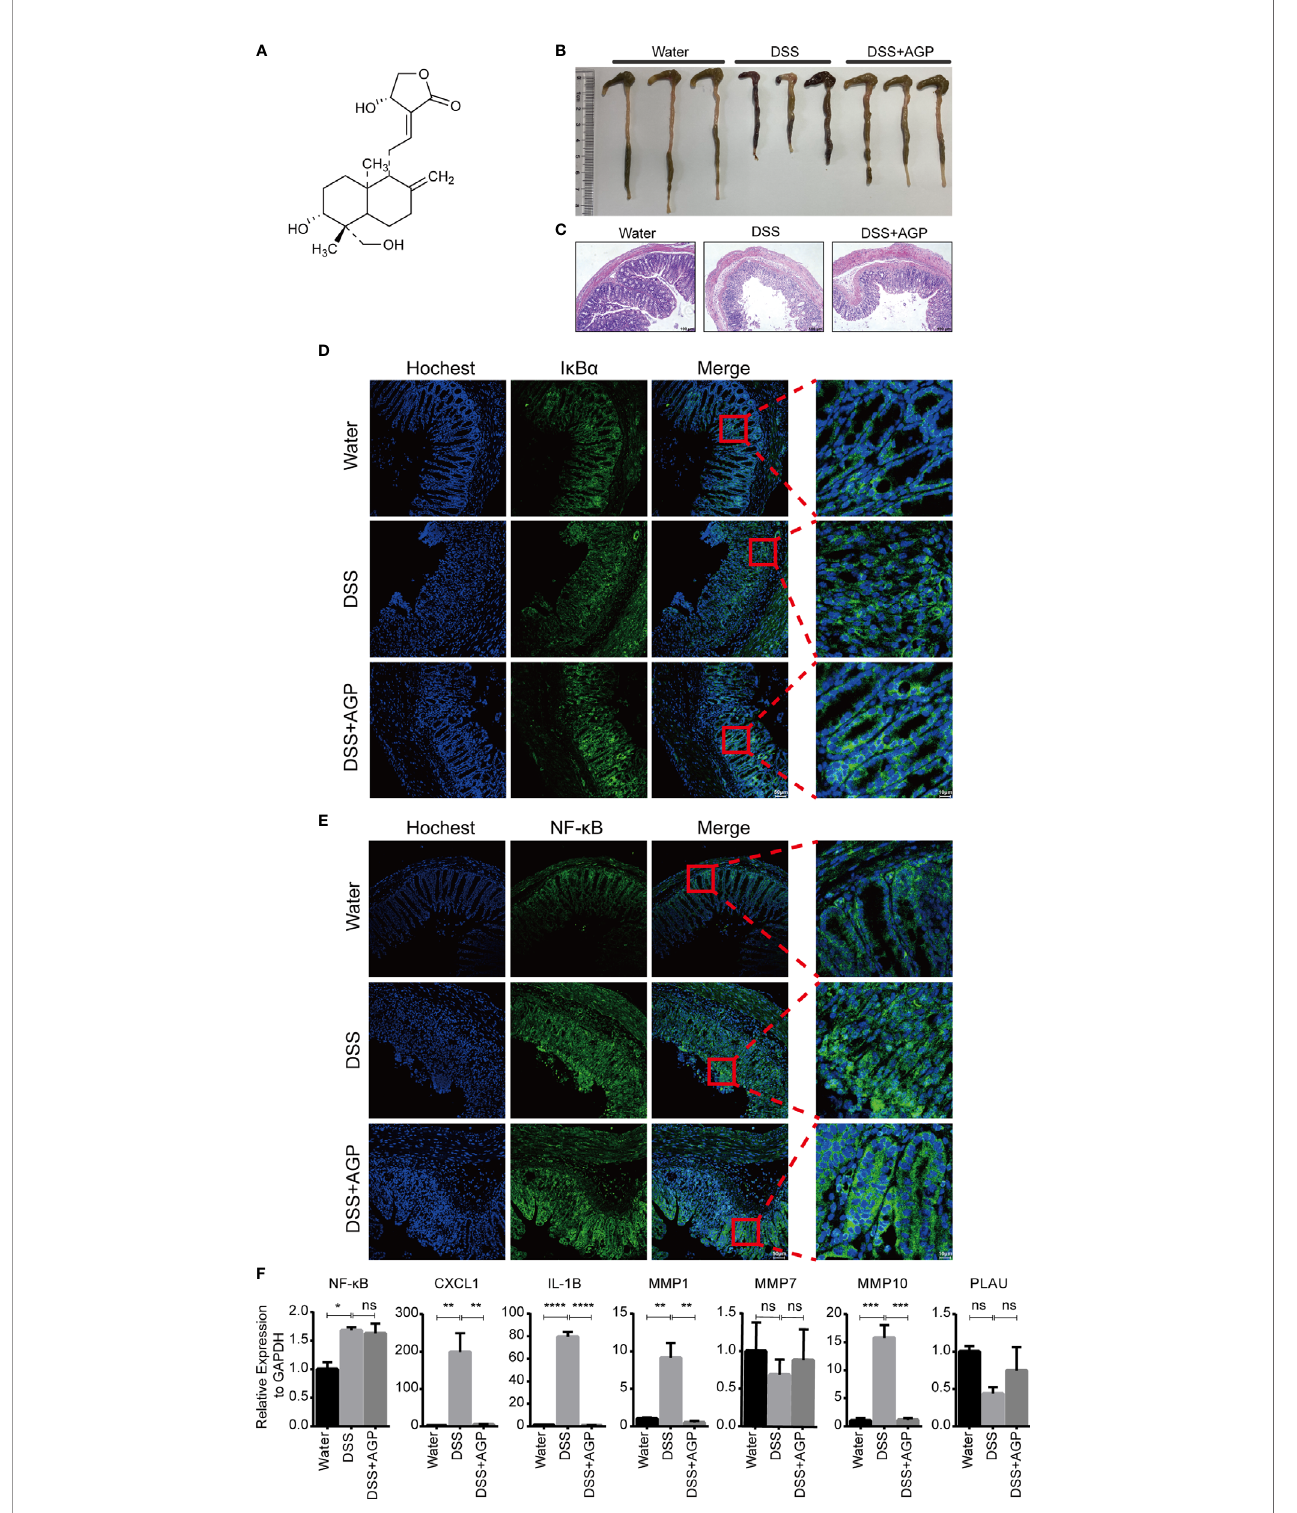
FIGURE 8 | AGP alleviated DSS-induced colitis. (A) The structure of AGP. (B) Colon length of mice during 3.5% DSS challenge. (C) Representative H&E staining of the colon at day 10 of colitis induction. (D, E) AGP prevents nuclear translocation of NF- k B without affecting I k B a . (F) RT-PCR analysis. *P < 0.05, **P < 0.01, ***P < 0.001, ****P < 0.0001, and ns, no signi fi cance (Student ’ s t-test). Error bars represent the